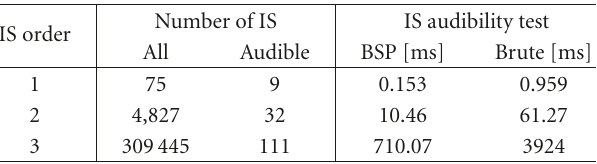
Table 2: Comparison of the measurement results of the IS audibil- ity test.